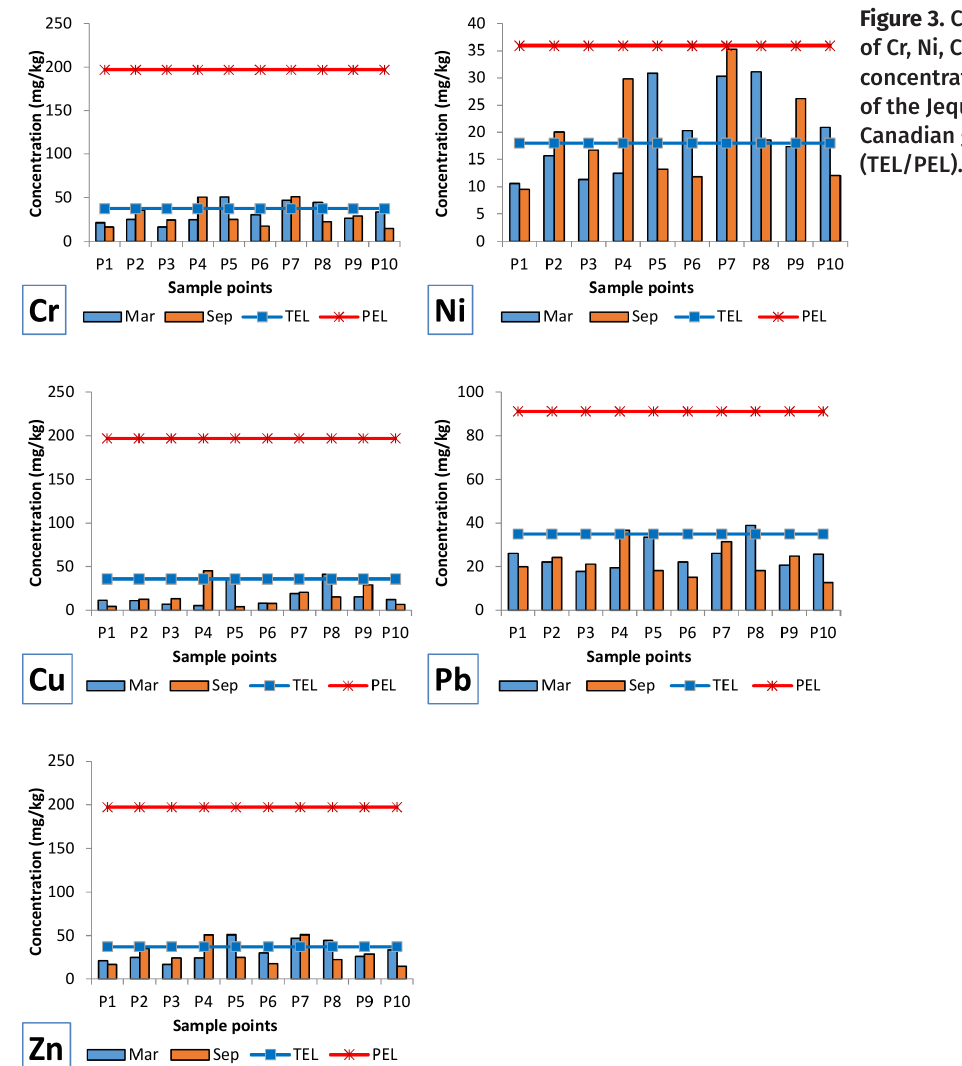
Figure 3. Comparison of Cr, Ni, Cu, Pb and